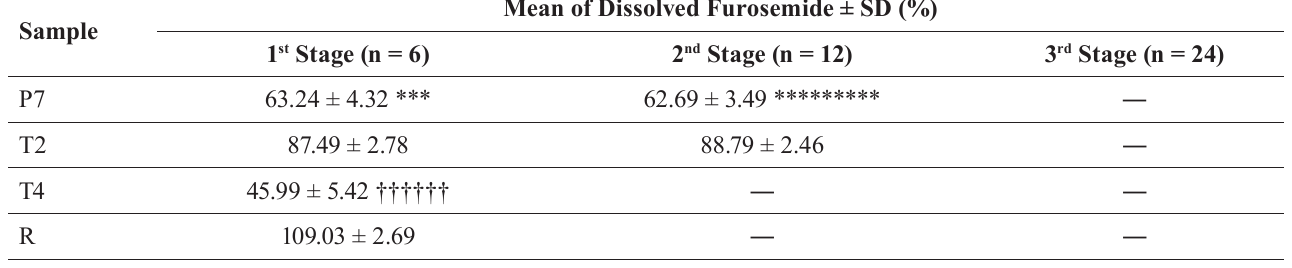
TABLE VI - Mean furosemide dissolution based on the percentage of the amount of furosemide declared on the label for compounded batches (P1 to P7), batches made in-house (T2 and T4) and batch of the reference medicinal product (R) after